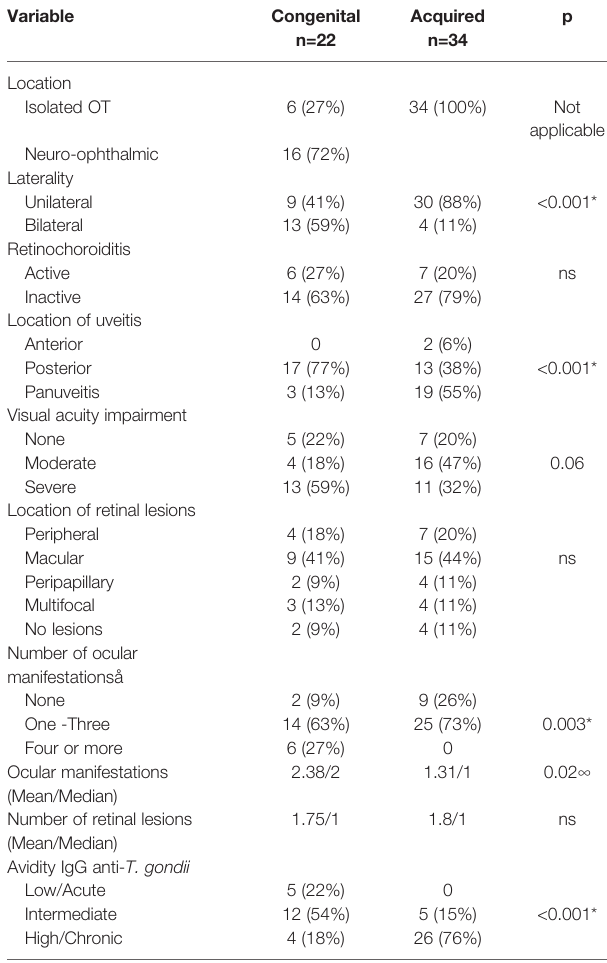
TABLE 1 | Clinical characteristics of patients with ocular